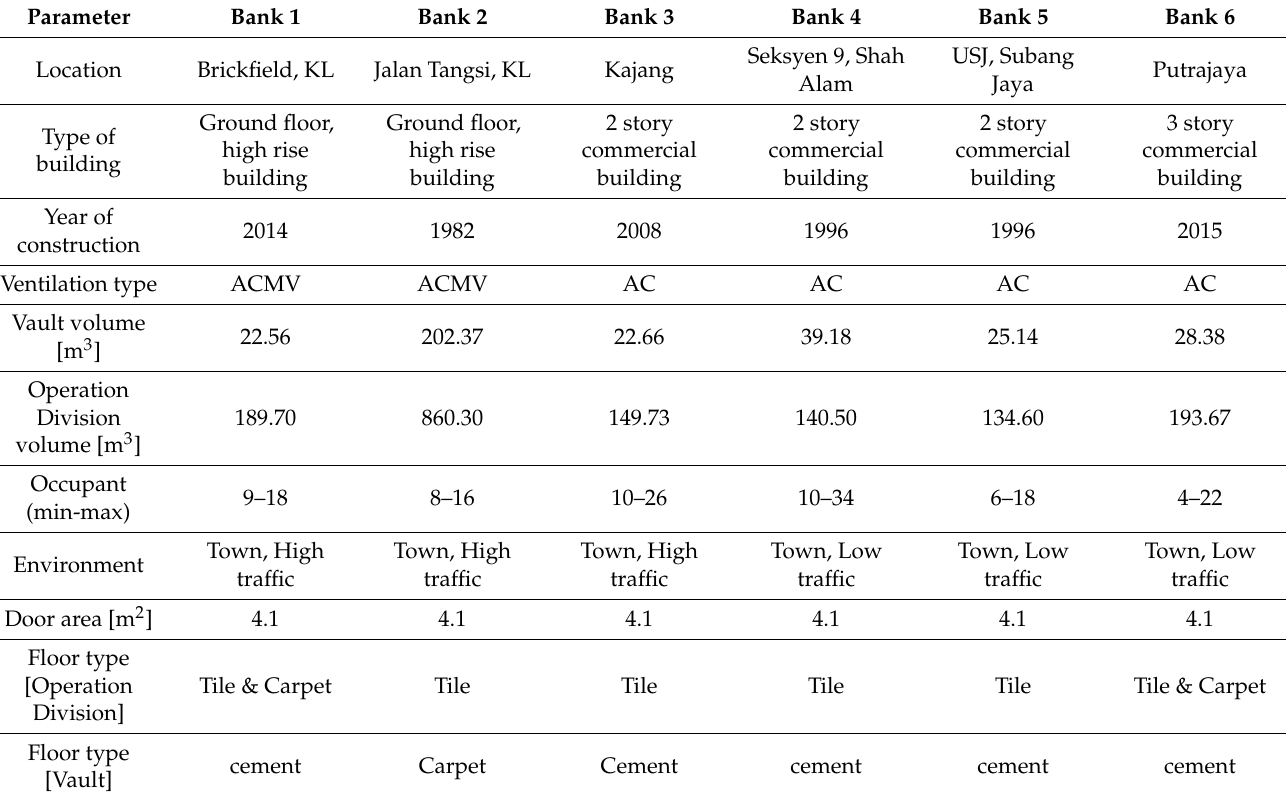
Figure 1. Location of banks. Table 1. Basic information about investigated bank